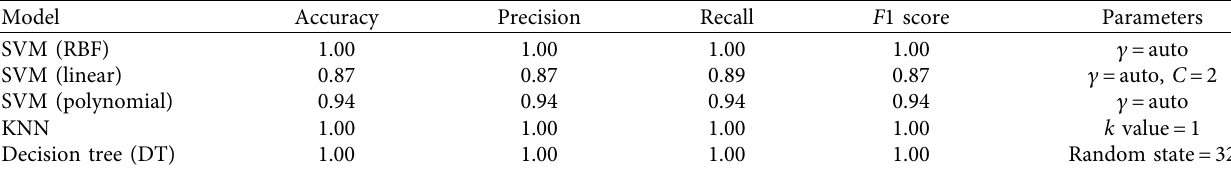
Table 11: Neuroticism classifcation report.